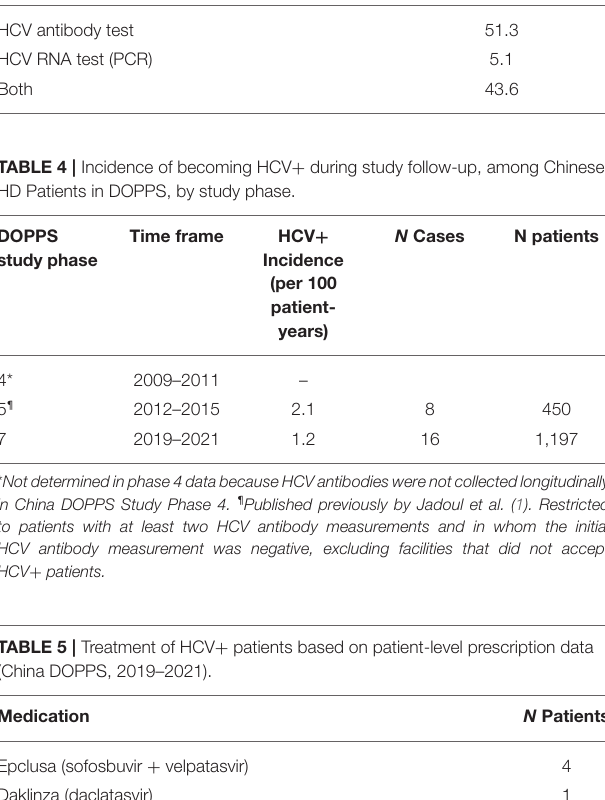
TABLE 3 | Method typically used for routine HCV screening in facility HD patients (China Medical Director HCV survey, 2021). HCV screening test